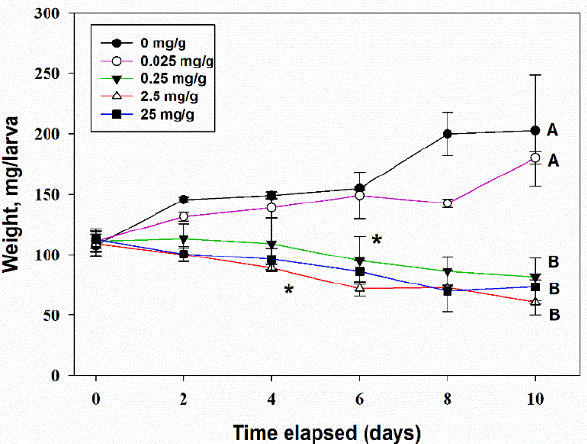
Figure 9. The effect of the concentration of tenuazonic acid in artificial feed on the growth of the biomass of Galleria mellonella larvae. Means ± std. deviation marked with the same letter did not differ significantly at the level of p = 0.05 according to Tukey’s HSD test. *—significant difference from control at p = 0.05 by Dunnett’s